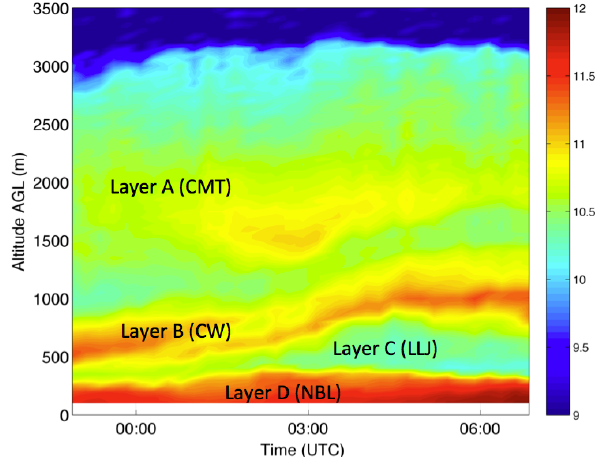
Figure 1. Time–height section of the logarithmic range corrected lidar signal (in arbitrary units) deduced from the Doppler lidar mea- surements during the night of 15–16 April 2015 at Mbour. The stratification is represented by four layers: (A) continentalized mar- itime trade (CMT); (B) layer advected mainly by a continental wind (CW); (C) low-level jet (LLJ); and (D) nocturnal boundary layer